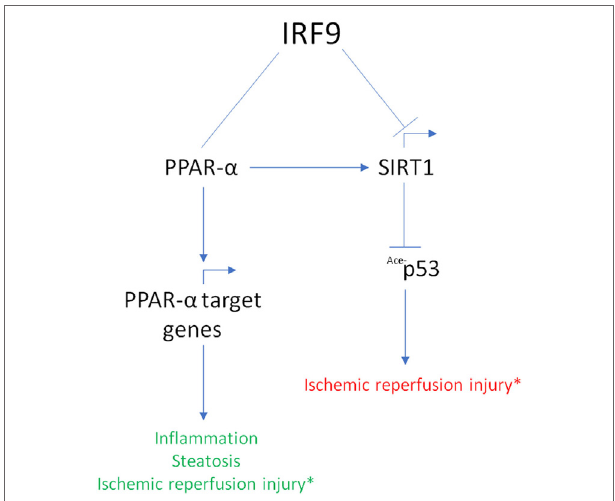
FiGURe 3 | Summary of interferon regulatory factor 9 (IRF9) interaction with the peroxisome proliferator-activated receptor α (PPAR α )–Sirtuin1 (SIRT1) axis. IRF9 exerts different effect in its interaction with the PPAR α –SIRT1 axis. IRF9 interacts with PPAR α and activates PPAR α target genes to attenuate inflammation, liver steatosis, and ischemic reperfusion (IR) injury. Whereas, IRF9 inhibits the expression of SIRT1 resulting in augmented acetylation of p53 protein. This results in a poor outcome in IR injury. PPAR α is also known to regulate SIRT1 gene expression. * Conflicting roles of IRF9 in the PPAR α –SIRT1 axis result in different outcome in IR injury (green font indicates better outcome; red font indicates worst